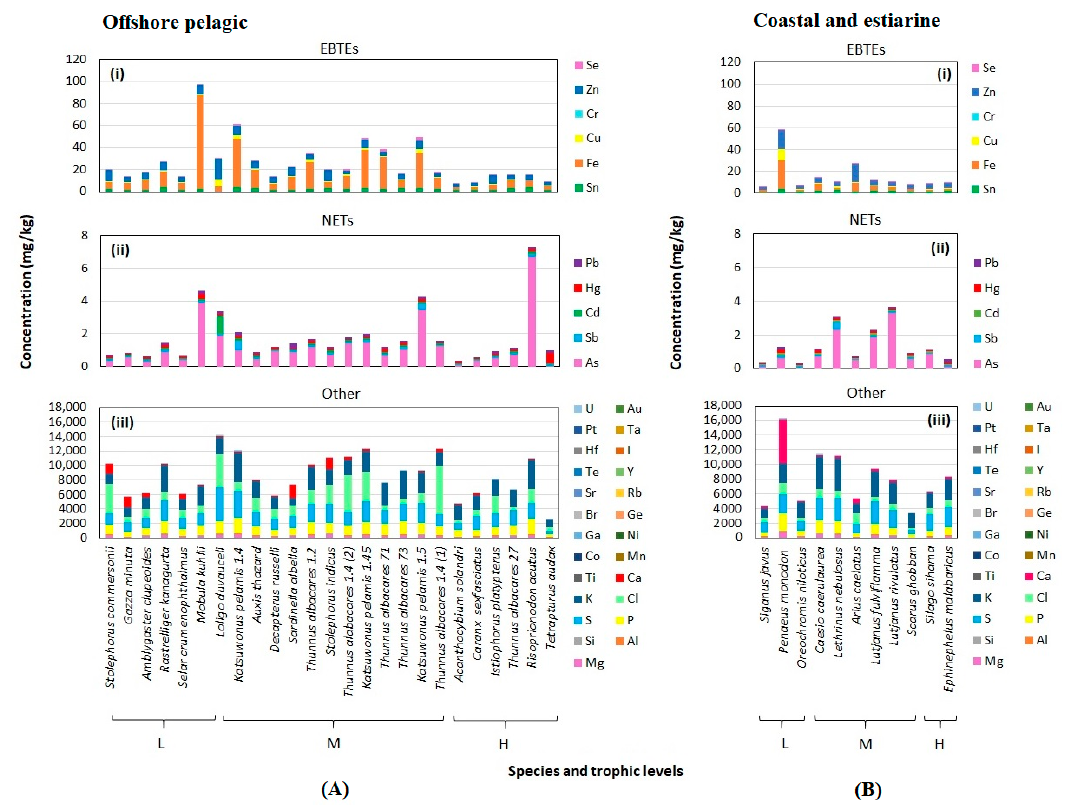
Figure 2. Concentrations of elements (mg/kg ww) are categorized into three groups: EBTEs: essential but toxic in excess quantities ( i ), NETs: non-essential toxic ( ii ), and Other ( iii ) among edible aquatic organisms collected in offshore pelagic ( A ) and coastal and estuarine ( B ) ecosystems in Sri Lanka. L = lower trophic level, M = middle trophic level, and H = higher trophic